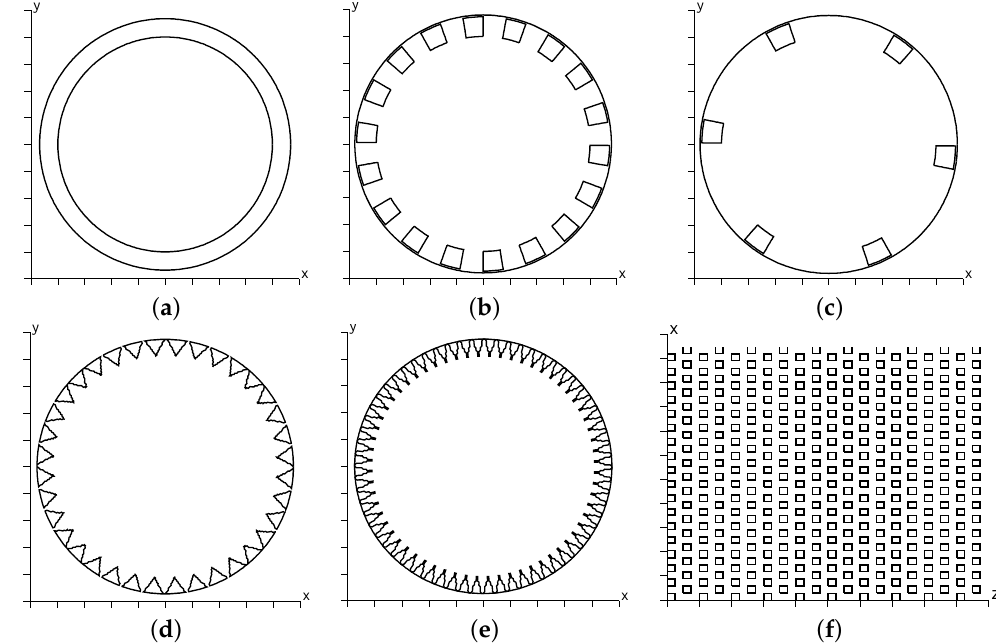
Figure 1. Sketch of roughness geometries in a cross-stream plane with − 1.2 < x < 1.2 and − 1.2 < u < 1.2: ( a ) SM ; ( b ) SL ; ( c ) SLL ; ( d ) TL ; ( e ) TLS ; ( f ) the CS geometry is depicted in a z − θ (0 < x = θ < 2 π and 0 < z < 8) shell at the plane of the